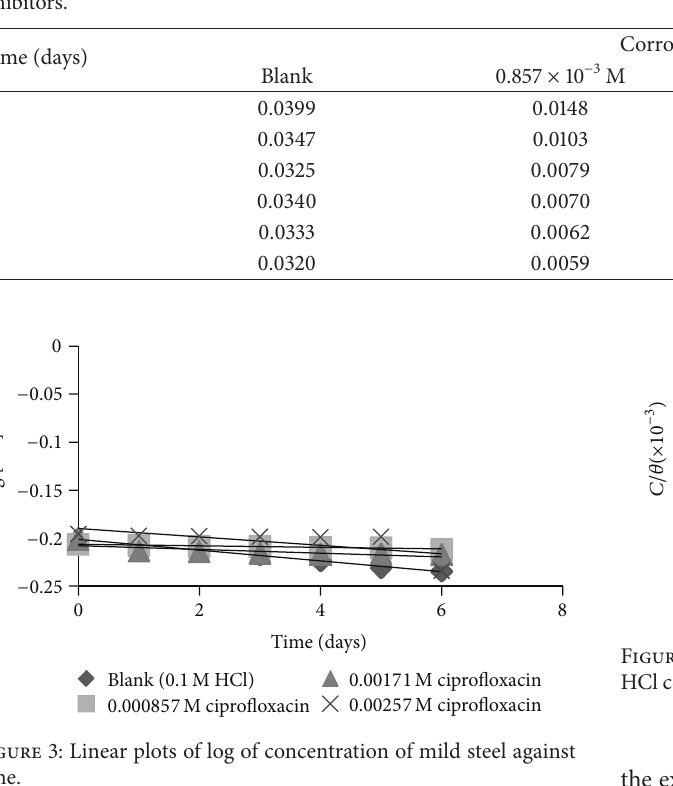
Table 2: Calculated values of corrosion rate of mild steel in 0.1M HCl solution in absence and presence of different concentrations of inhibitors.